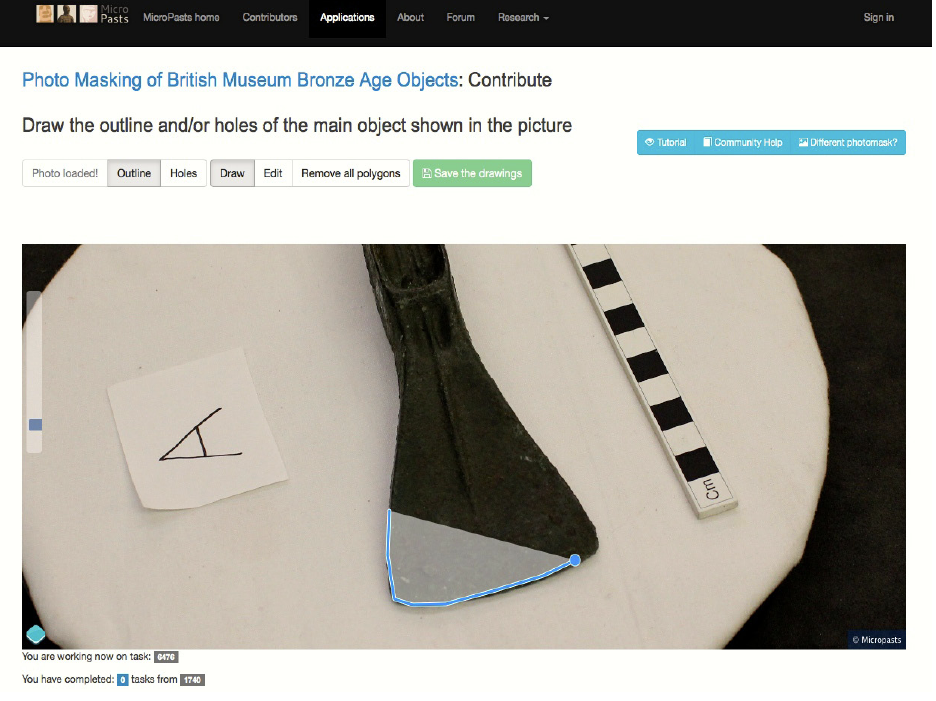
Fig. 4: Interface of the photo-masking application.